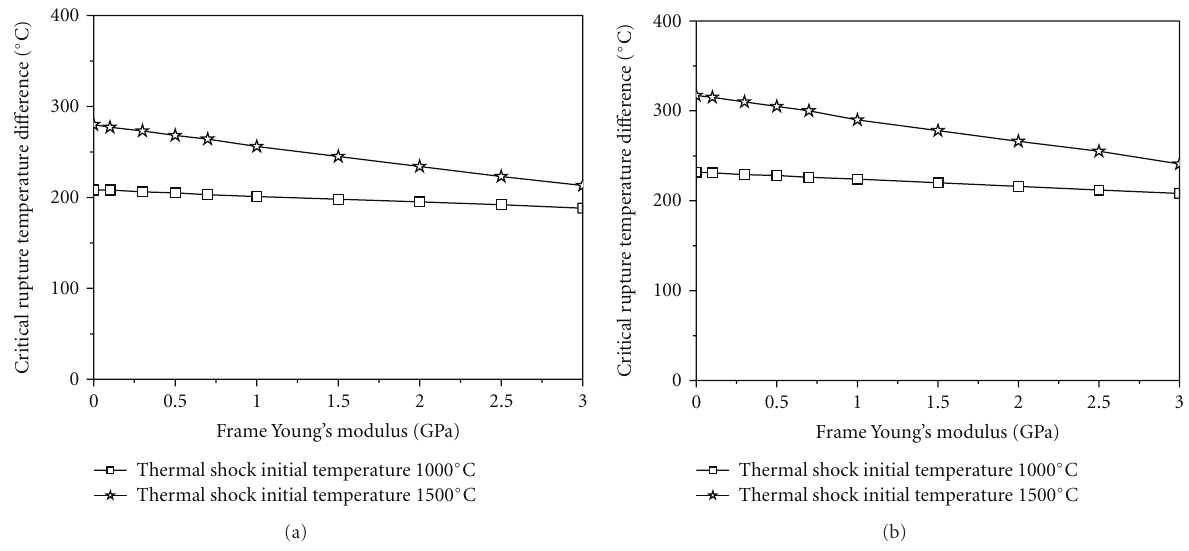
Figure 4: The critical rupture temperature di ff erence versus frame Young’s modulus for di ff erent thermal shock initial temperature with the same heating rate (a) 320 ◦ C · s − 1 and (b) 2000 ◦ C · s − 1 .